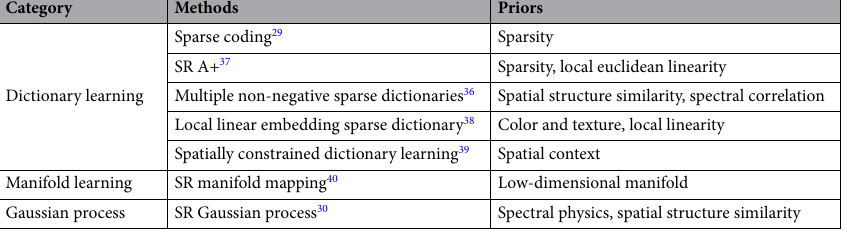
Table 2. An overview of prior-based spectral reconstruction